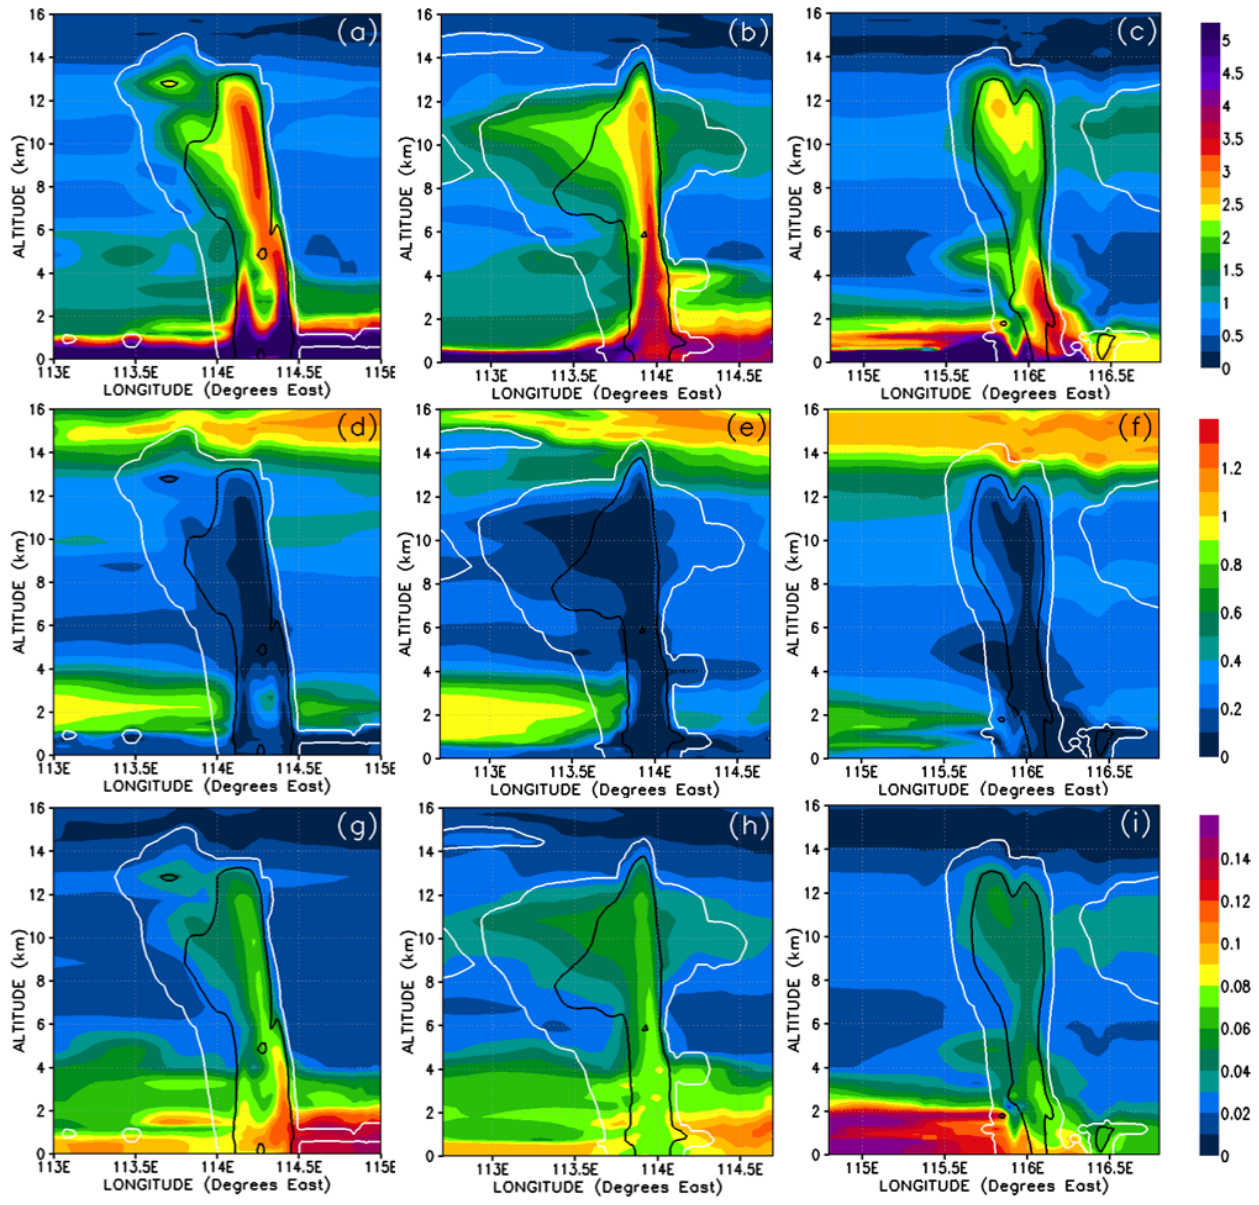
Figure 9. Vertical cross sections of mixing ratios (expressed in Br pptv) of CHBr 3 (a–c) , inorganic (d–f) , and organic (g–i) bromine com- pounds. The left, middle, and right columns correspond to cross sections of Mod_Conv_4.35N at 4.35 ◦ N at 06:00UTC, Mod_Conv_3.75N at 3.75 ◦ N at 09:00UTC, and Mod_Conv_5.4N at 5.4 ◦ N at 09:00UTC. The white and black lines represent the 0.01 and 0.5gkg − 1 contours of the simulated condensed water (cloud and precipitation in ice and liquid phase), respectively. Note that panel (c) is identical to Fig. 8c except scaled upwards by three for the number of bromine